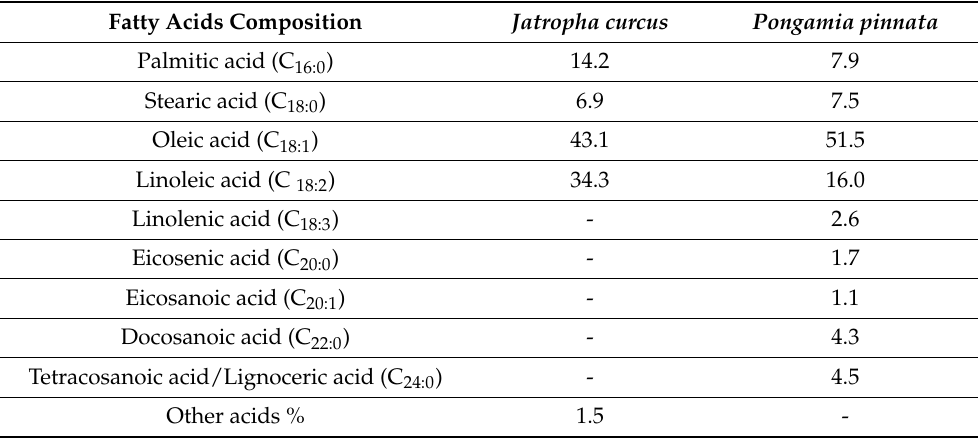
Table 2. Composition (weight %) of fatty acids in raw/virgin Jatropha and Pongamia oils [38]. Fatty Acids